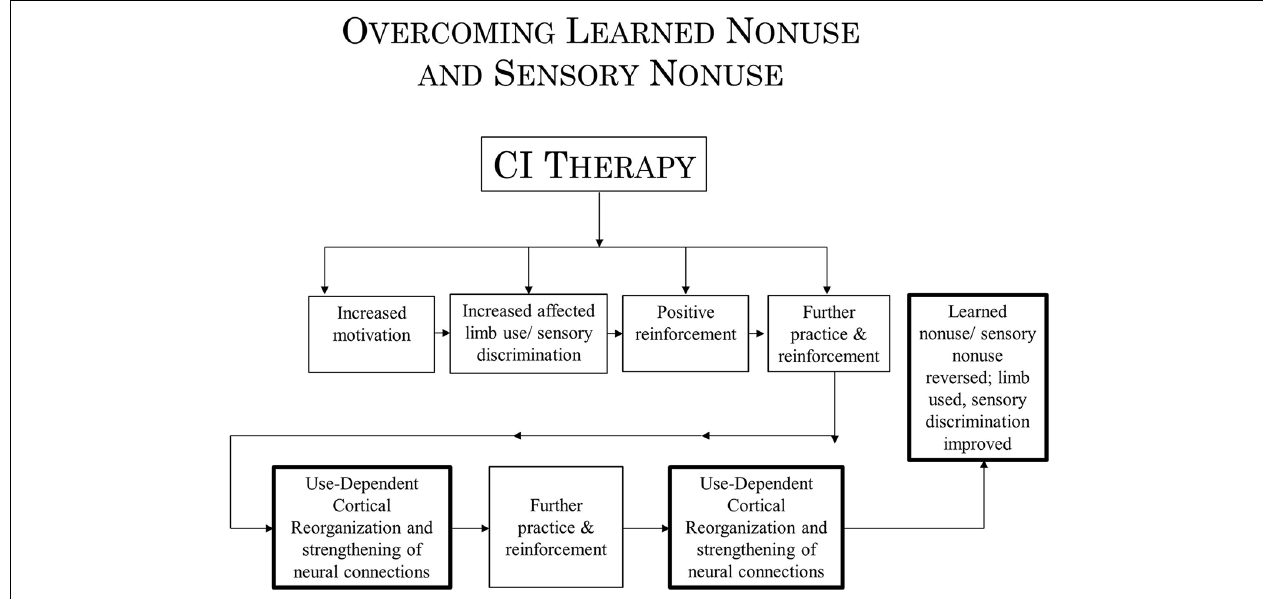
FIGURE 9 | Schematization of the process by which CI therapy overcomes learned nonuse and sensory